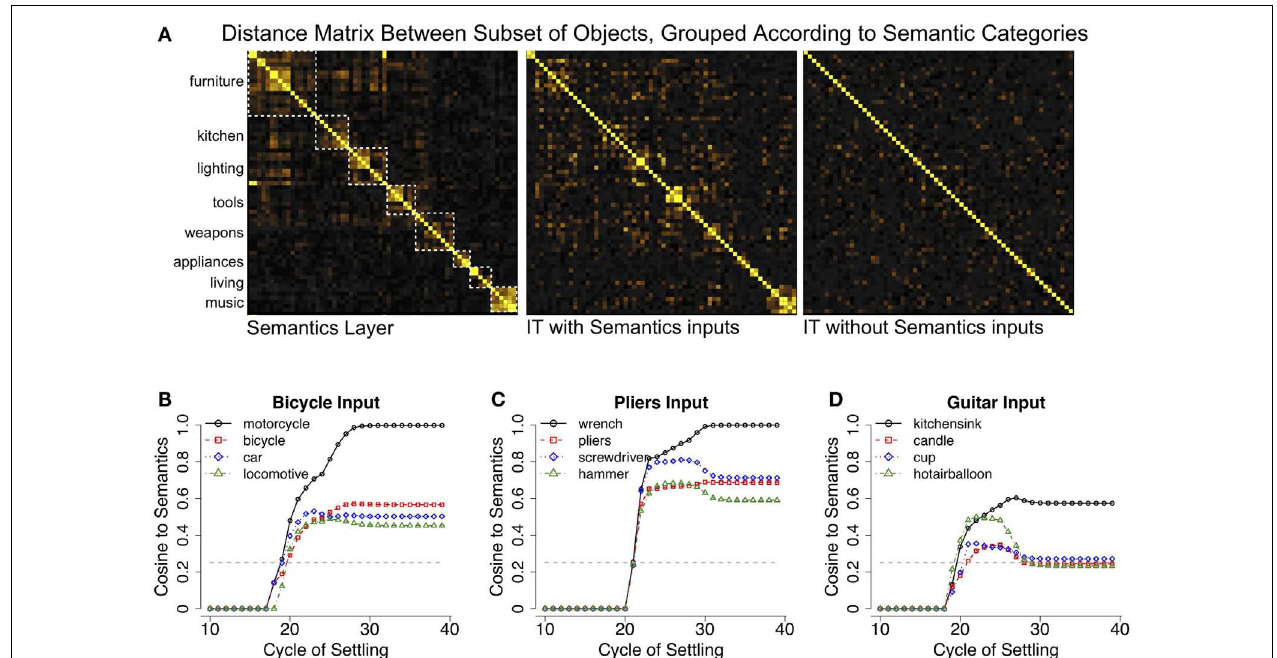
bicycle image was presented to a network that was not trained on bicycles, showing cosine similarities of the current semantics activation pattern to the canonical semantics for indicated categories.The network interprets the bicycle as a motorcycle (closest trained category), but the semantics layer representation actually has bicycle as its second closest pattern, indicating that it can infer veridical semantic properties from visual appearance.The dotted gray line indicates the mean similarity of the input semantics to the semantics of all other categories, which was 0.25 for the categories tested here. ( C) Similar results for a pliers image, which was also not trained. ( D) Guitars did not exhibit obvious visual similarity to semantically related trained items, and thus, the model was unable to infer their semantic